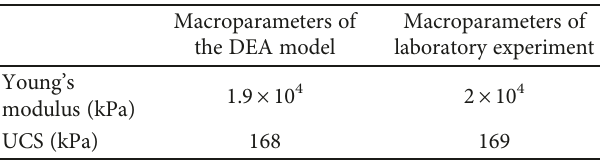
Figure 7: (a) Particle distribution curve; (b) soil water characteristic curve (SWCC); (c) relationship between the relative hydraulic conductivity and the saturation based on the hydraulic conductivity function Table 2: Comparison between macroparameters of DEA model and laboratory experiment.